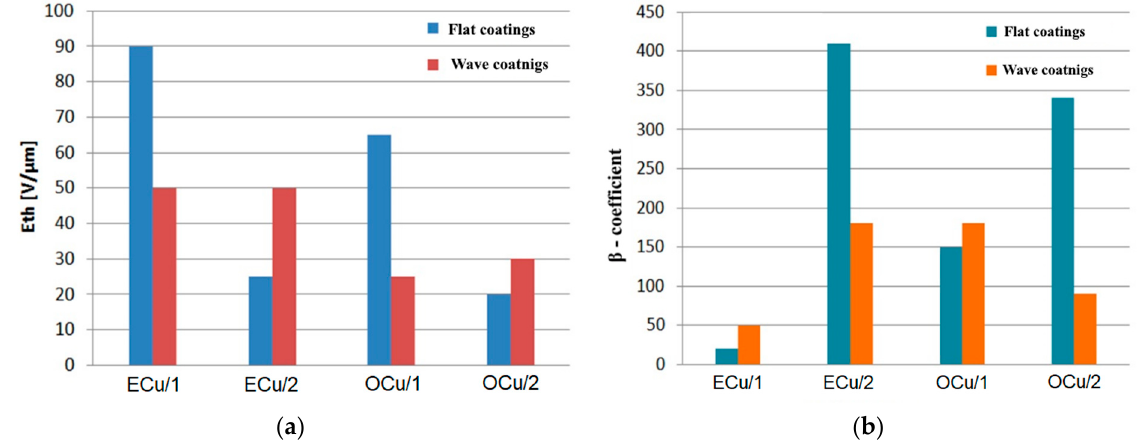
Figure 12. The threshold electric field, E th ( a ) and coefficient of electric field amplification, β ( b ) of tested samples. Table 3. Composite coatings characterization.